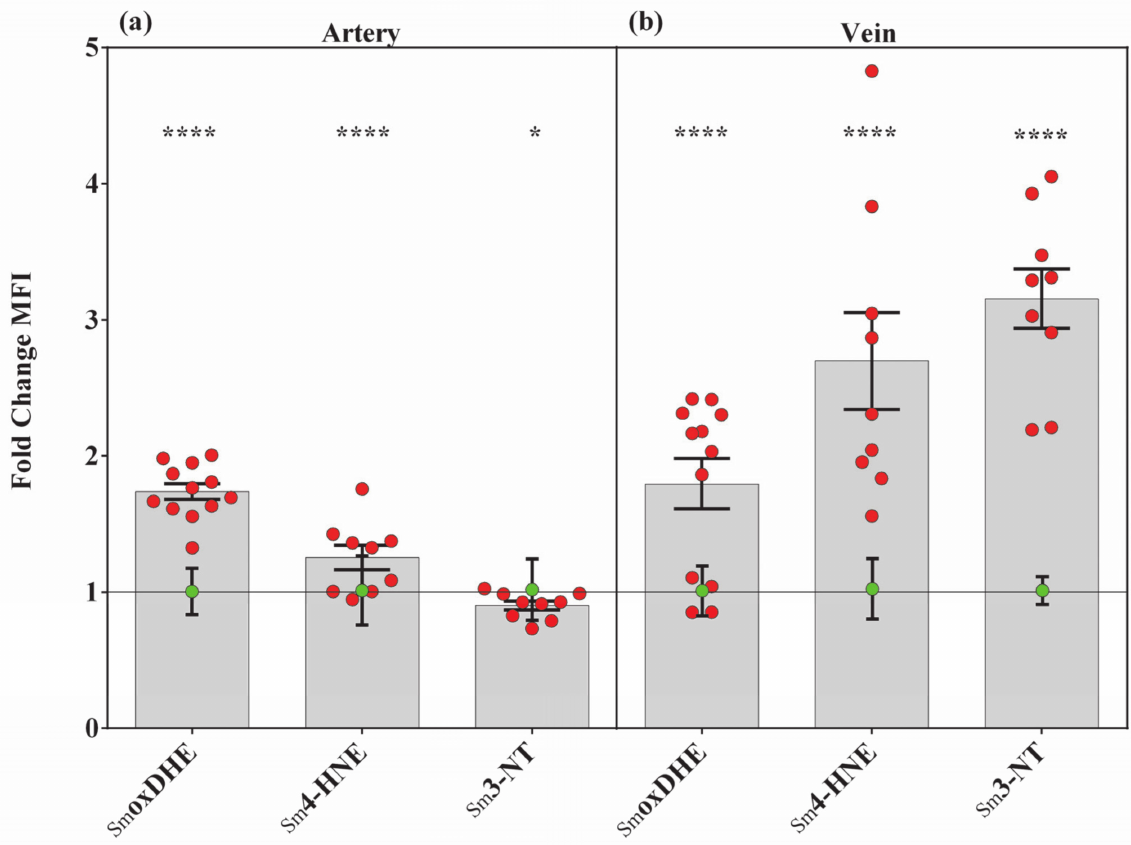
Figure 2. Changes in oxidative stress markers among Sm-derived UC vessels. Bar graphs showing the semiquantified results of 4-HNE, 3-NT specific immunolabeling and the intercalated redox indicator dihydroethidium staining (DHE) levels in Sm arteries ( a ) and in Sm veins ( b ). Red dots symbolize the overall mean fluorescence intensity (MFI) values from individual Sm samples, while green dots refer to summarized data from the Ctrl group, applied as the baseline of comparison (mean ± SEM). Sample numbers: CtrloxDHE ( n = 304 artery and 929 vein regions of interest (ROI) from 12 individual samples); SmoxDHE ( n = 961 artery and 1229 vein ROI from 12 individual samples), Ctrl4-HNE ( n = 233 artery and 589 vein ROI from 11 individual samples); Sm4-HNE ( n = 232 artery and 448 vein ROI from 9 individual samples); Ctrl3-NT ( n = 1033 artery and 44 vein ROI from 11 individual samples); Sm3-NT ( n = 277 artery and 39 vein ROI from 9 individual samples). Statistics: unpaired t -test followed by Mann–Whitney test to compare ranks * p ≤ 0.05, **** p ≤